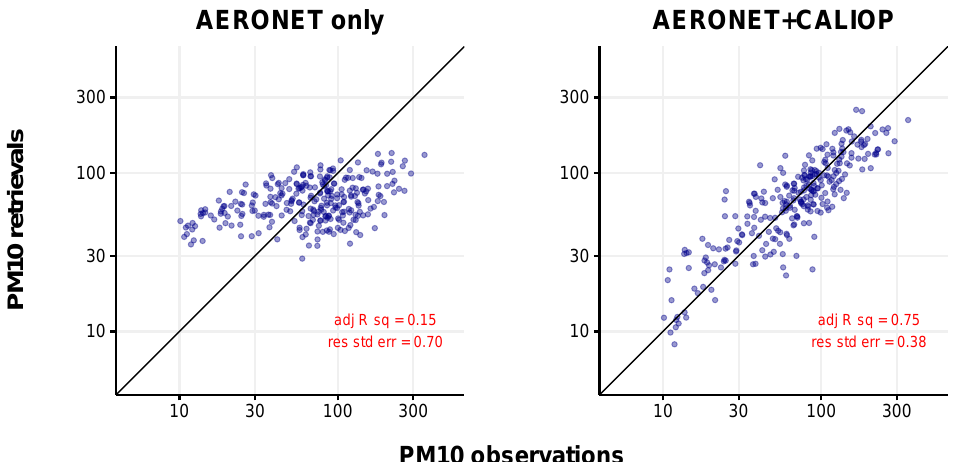
Figure 4. Scatter plot of measured and predicted monthly PM10 in µ g/m 3 considering ( left ) AERONET AOD only and ( right ) AERONET AOD and CALIOP parameters. Number of points N = 280, ajd R sq is the adjusted coefficient of determination, and res std err is the residual standard